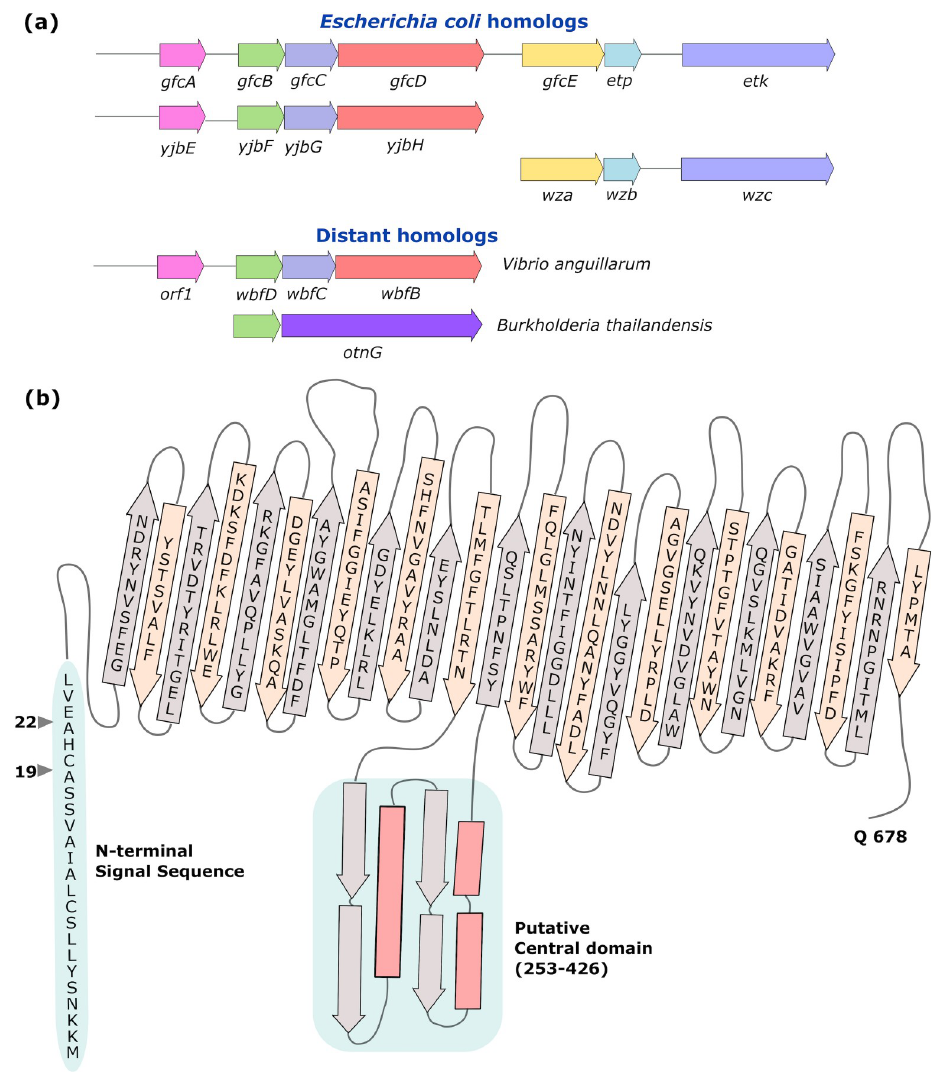
Fig 1. Group four capsule operon and GfcD. (a) The Escherichia coli group 4 operon consists of seven genes. The genes gfcA , gfcB , gfcC , and gfcD encode proteins of an unknown function. Genes gfcE , etp , and etk share homology with proteins of Group 1 capsule export systems. Distant homologs are also found in Vibrio and Burkholderia sp ecies. (b) Membrane topology of GfcD as predicted by HHOMP and classified as a potential outer membrane β -barrel protein. The central region (273–427) is devoid of transmembrane strands and may be an independently folded domain with the predicted secondary structure shown. The signal sequence at the N-terminus (shaded blue) shows a putative signal peptidase II cleavage and acylation site (arrow 19) as previously annotated, and the peptidase I cleavage site (arrow 22) revealed in the present work by MALDI-TOF and N-terminal sequencing.